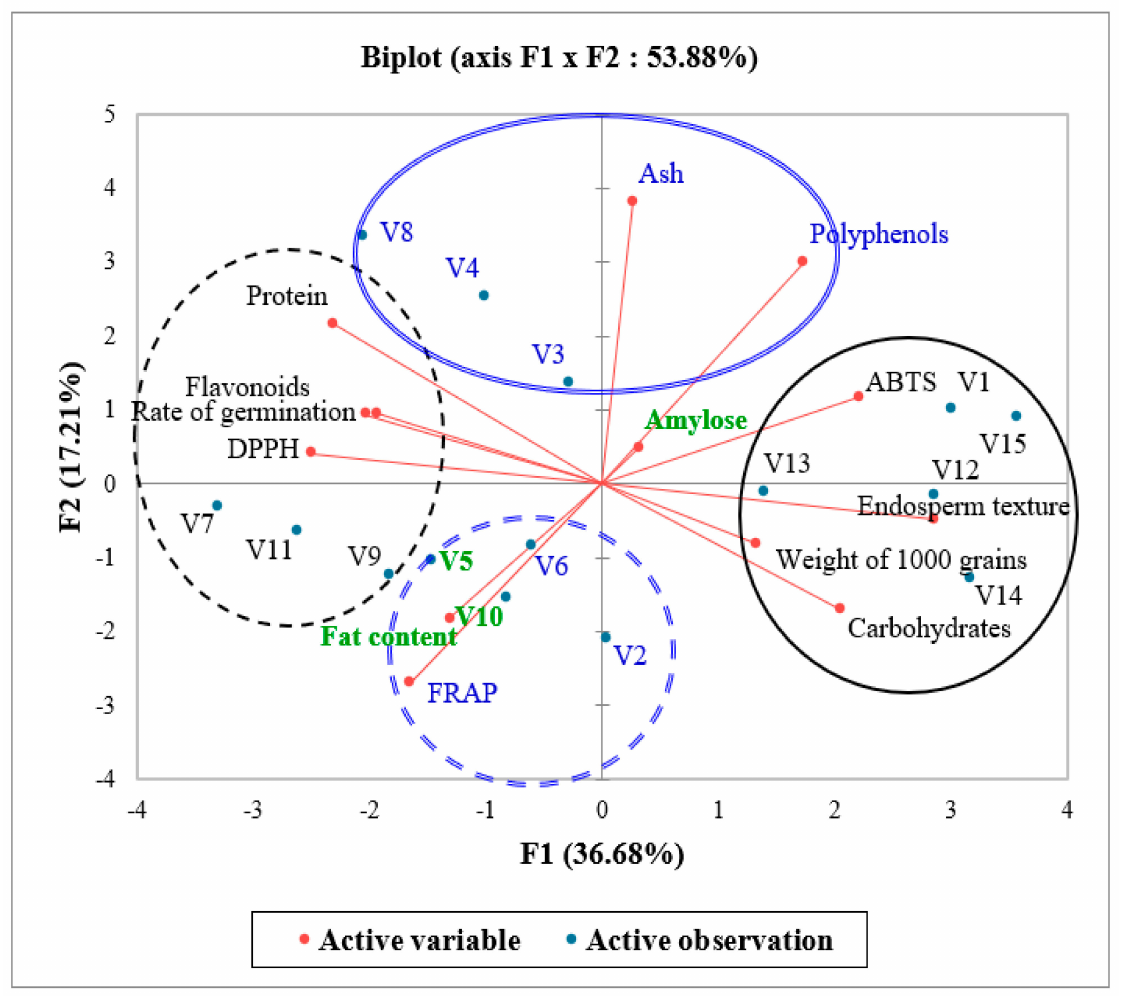
Figure 2. Principal component analyses based on grains